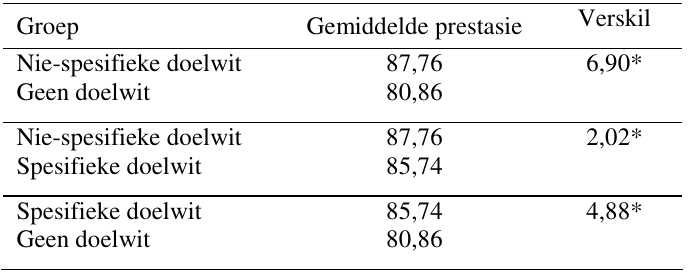
BEDUIDENDE VERSKILLE TUSSEN GEMIDDELDE